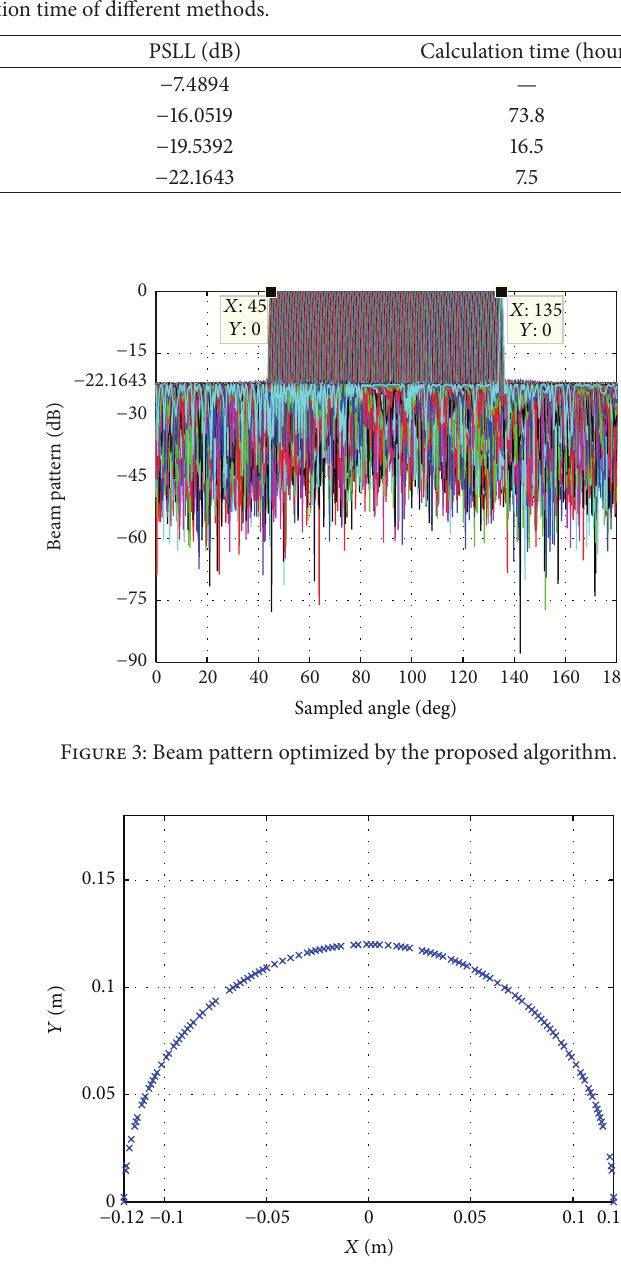
Figure 4: Elements’ distribution of the proposed